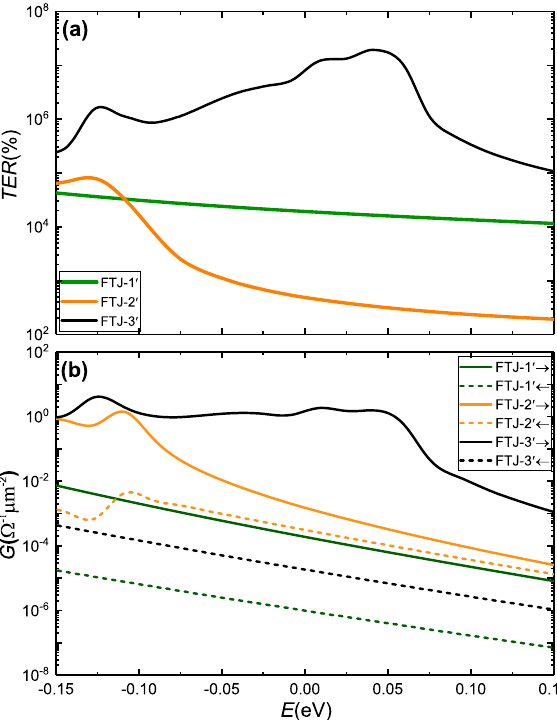
Fig. 7 TER and conductance G calculated by quantum-mechanical tunneling model. a TER of the FTJ 1 ′ – 3 ′ as a function of E . The curves of insets show the corresponding tunneling potential pro fi les, blue for polarization pointing to the left and red for polarization pointing to the right. The arrows indicate the directions of the polarization. b Conductance G per lateral area of FTJs as a function of energy E for polarization pointing right (solid) and left (dotted). The Fermi energy is at zero. Green, orange, black lines represent FTJ 1 ′ – 3 ′ ,